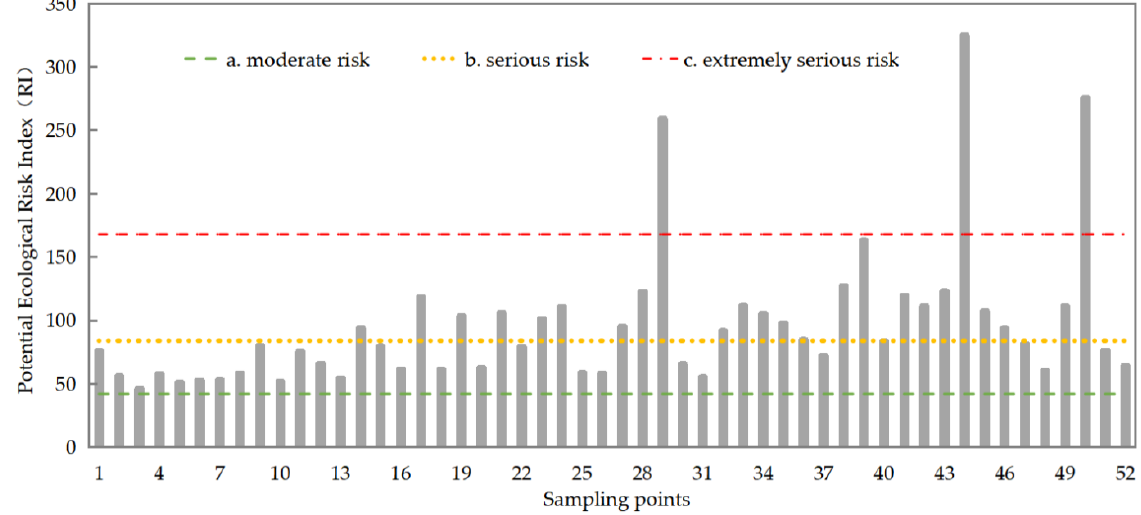
Figure 3. The ecological risk index of heavy metals at different sampling points.